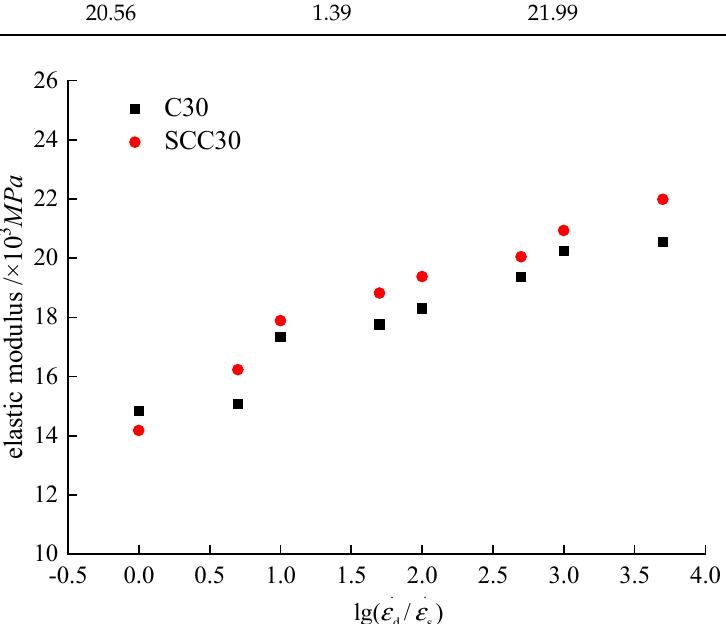
Figure 10. Relationship between strain rate and elastic modulus.